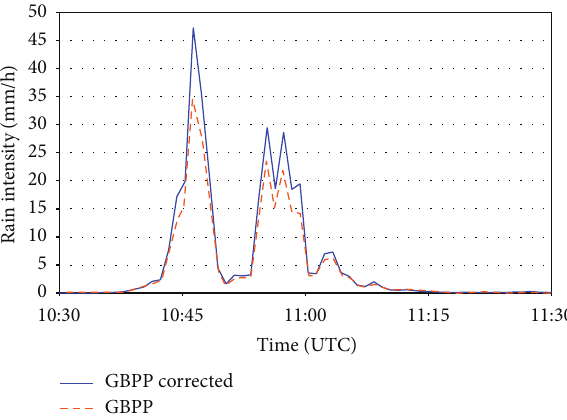
Figure 10: Rainfall intensities calculated with the sampling area uncorrected ( GBPP ) and corrected ( GBPP corrected ) during the most intense rainfall episode.